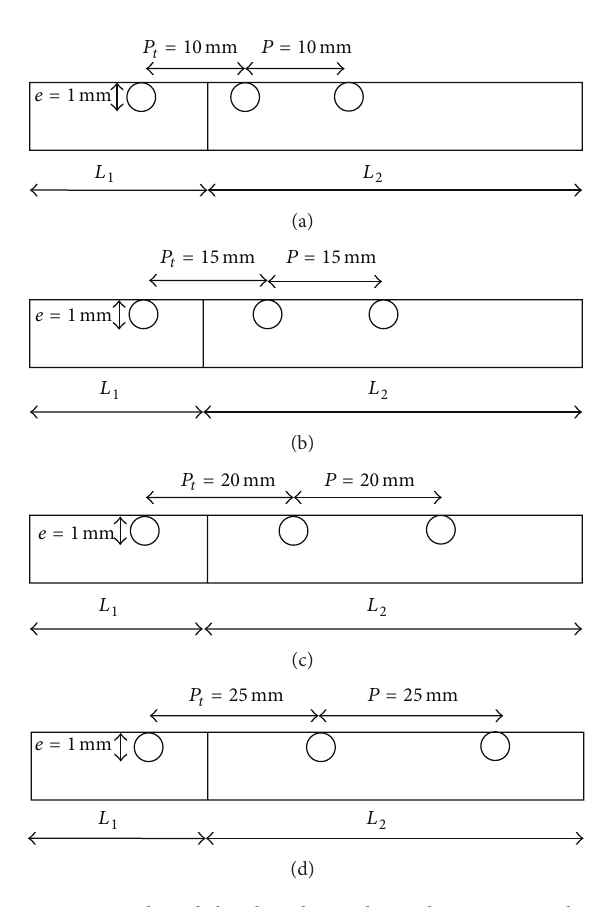
Figure 2: Roughened absorber plate with circular transverse ribs at a pitch of (a) 𝑃 = 10mm, (b) 𝑃 = 15 mm, (c) 𝑃 = 20 mm, (d) 𝑃 = 25 mm, and circular vortex generator in inlet section at a transverse pitch of (a) 𝑃 𝑡 = 10mm, (b) 𝑃 𝑡 = 15 mm, (c) 𝑃 𝑡 = 20 mm, and (d) 𝑃 𝑡 = 25